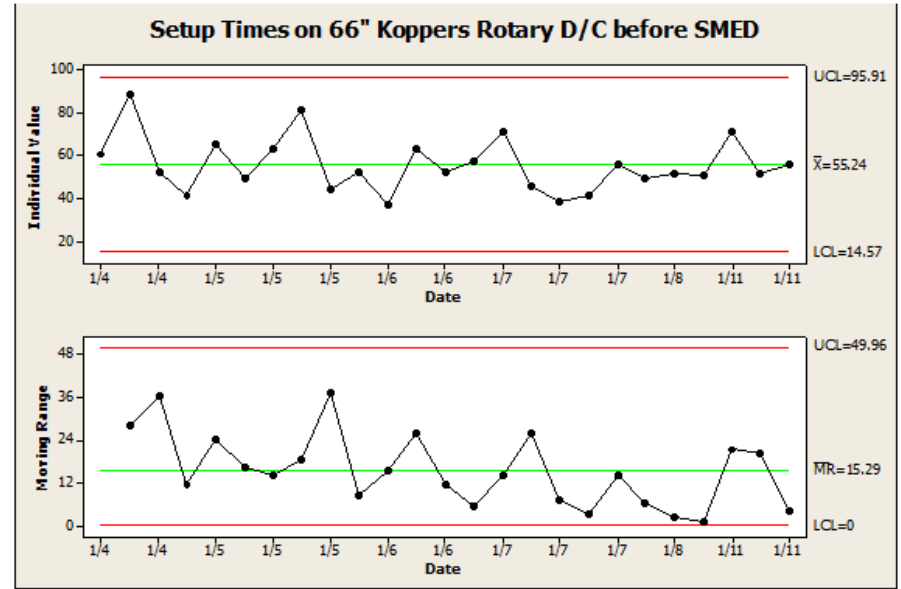
Fig. 1. Setup times during the last 25 setups before